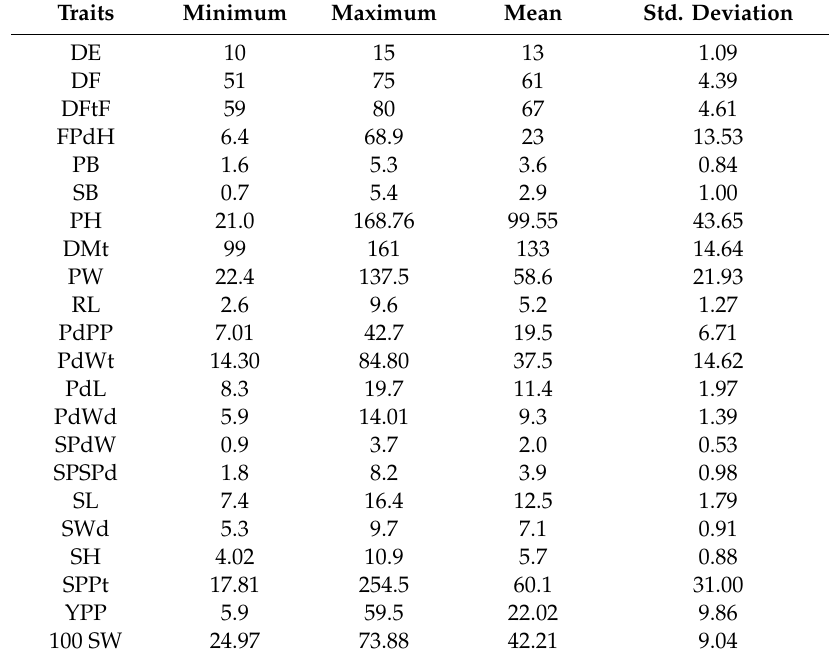
Table 3. Values of mean, maximum, minimum and standard deviation (Std) for the 22 di ff erent traits determined in the 183 Turkish common bean accessions.